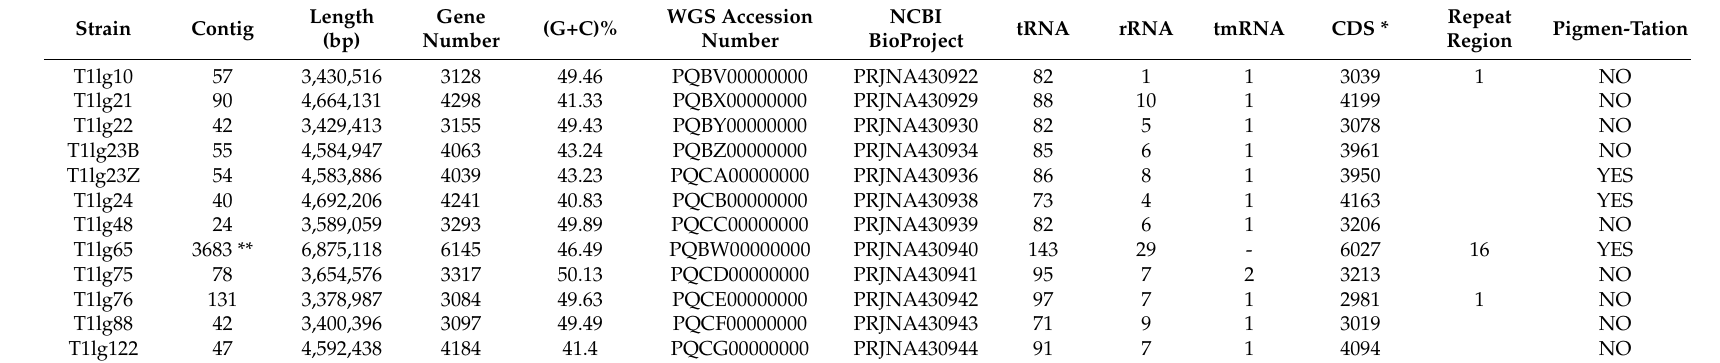
Table 2. Genomic characteristics of twelve Pseudoalteromonas i solates in this